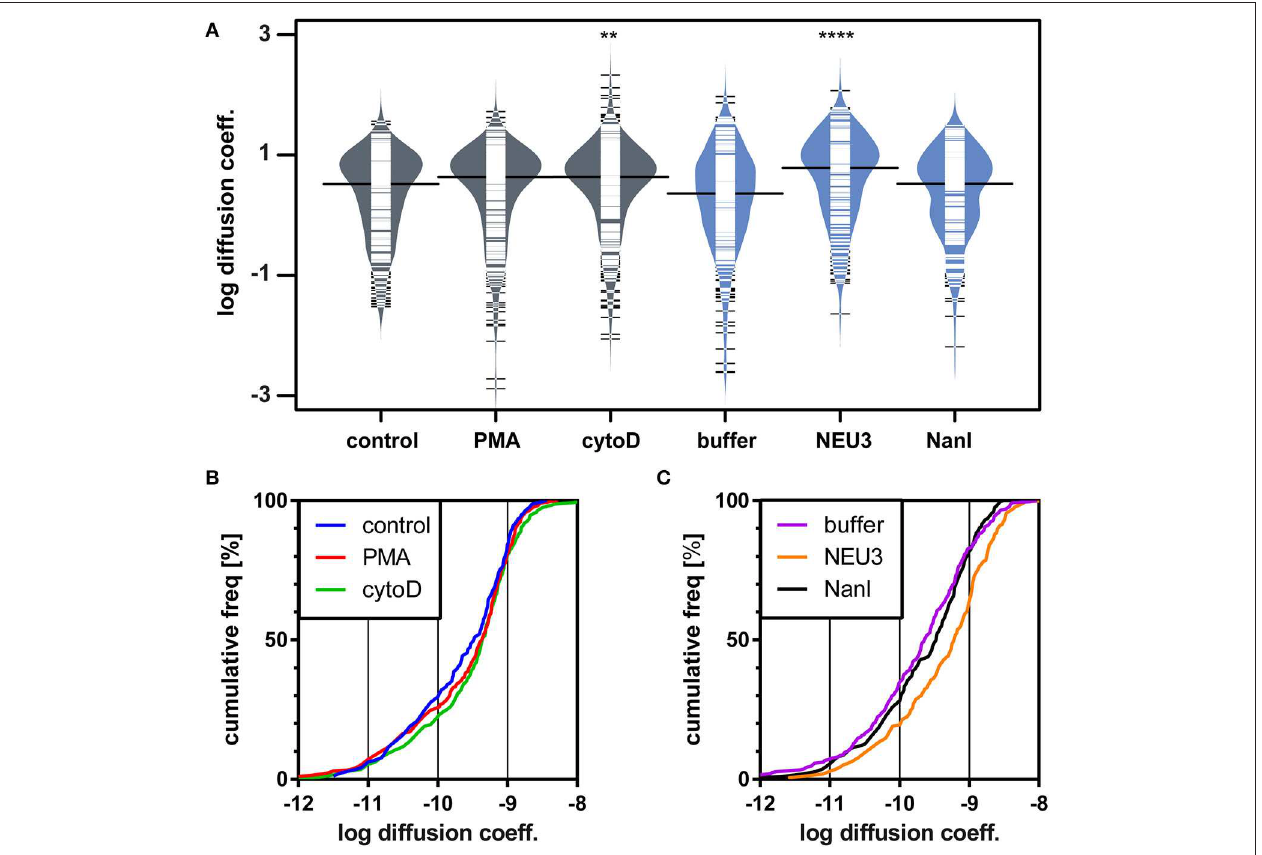
FIGURE 5 | LFA-1 diffusion is altered by NEU treatment. The lateral mobility of LFA-1 on Jurkat was determined using SPT. (A) A beanplot of each population is shown with the logarithmic median of diffusion coefficients indicated by a solid line for each population (same data as in Table 1 ) (Kampstra, 2008). Each population is shown with a density estimate and horizontal lines indicate individual diffusion coefficient measurements. (B) A cumulative frequency distribution is shown for the control, PMA, and cytoD conditions. (C) A cumulative frequency distribution is shown for the buffer, NEU3, and NanI conditions. Diffusion coefficients are given as log(D), where D is in units of × 10 − 10 [cm 2 s − 1 ] or × 10 − 2 [ µ m 2 s − 1 ]. Data were compared to the appropriate control using a t -test to determine p -values; ** p ≤ 0.01; **** p ≤